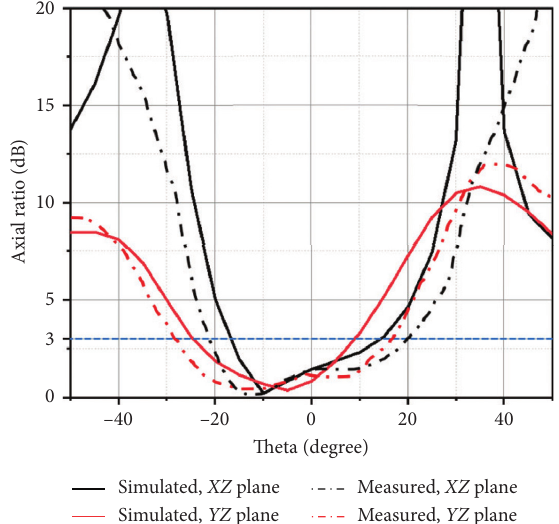
Figure 10: Simulated and measured AR as a function of θ angle from the broadside, in the XZ and YZ planes at 5.8GHz. Table 2: Performance comparison with other proposed dual-band dual-port CP antenna systems.